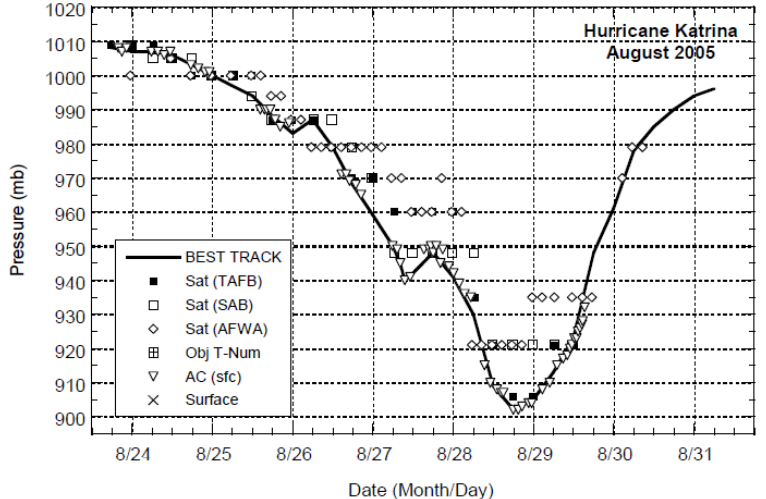
Figure 4. Best track positions for Hurricane Katrina, 23–30 August 2005 taken from NHC [9,10].